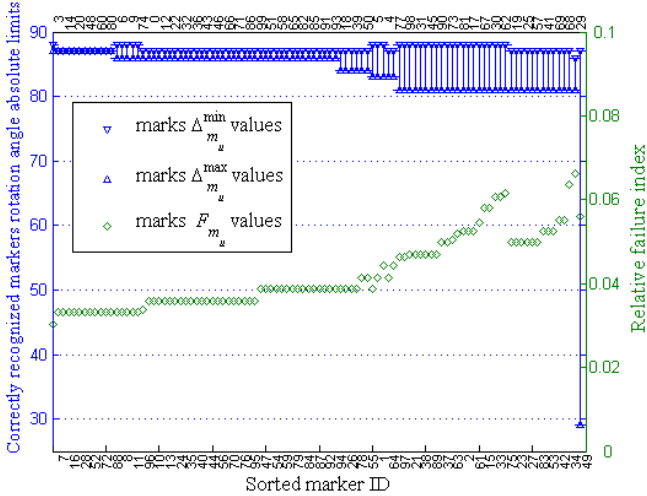
Fig. 9. Marker recognition results sorted using two-fold criteria: (4a) and (5) . Note: marker IDs are shown pair wise at the bottom and the top of axis; boundary between A and B marker classes is indicated by dash line.